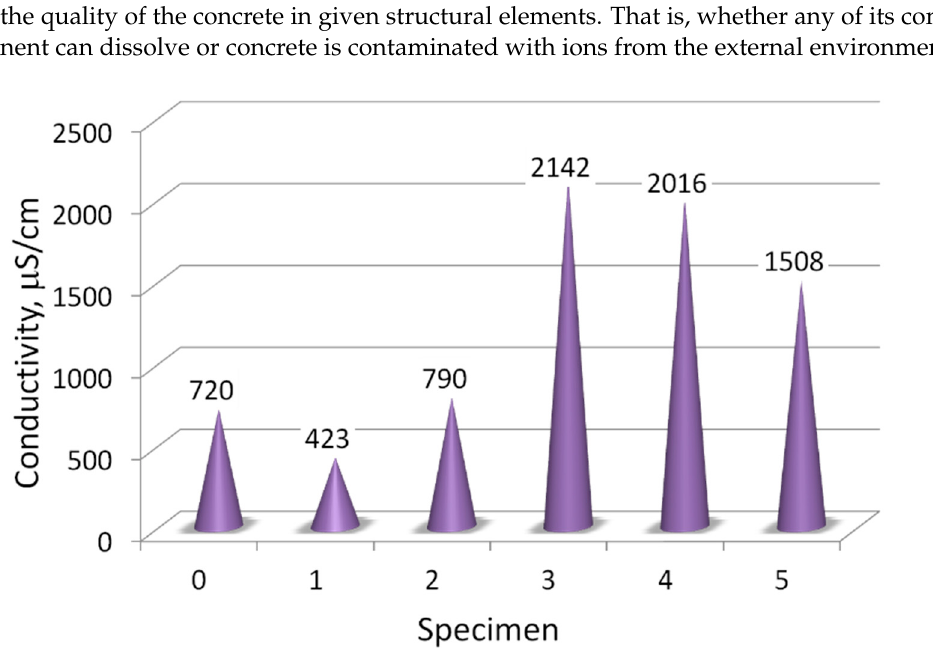
Figure 12. The conductivity of filtrates made of concrete samples from the